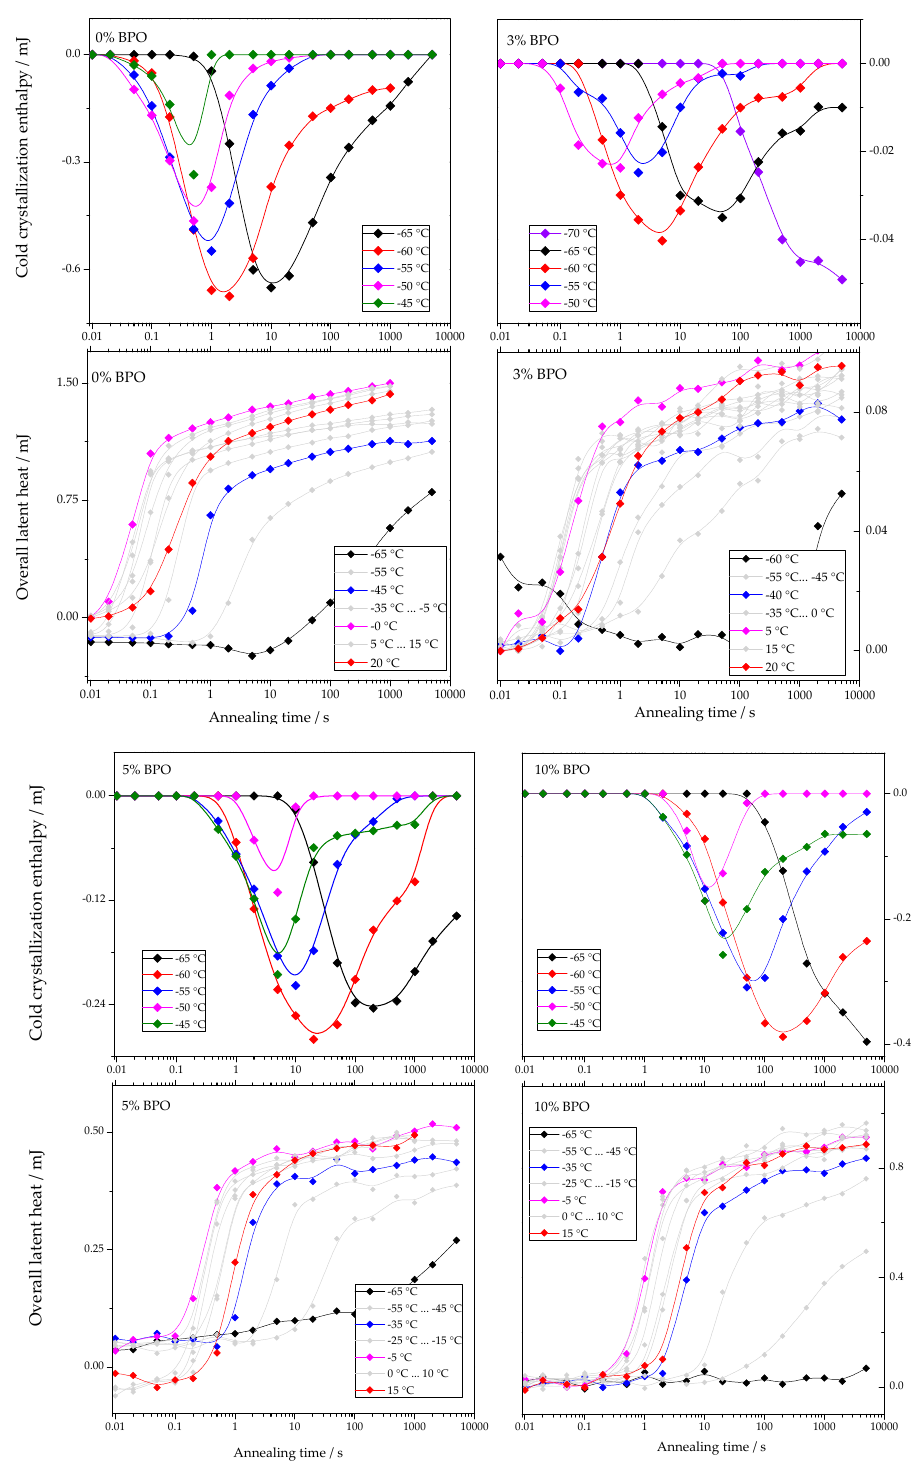
Figure 4. Dependence of cold-crystallization enthalpy and overall latent heat on annealing time and temperature upon heating the cross-linked PCL samples.